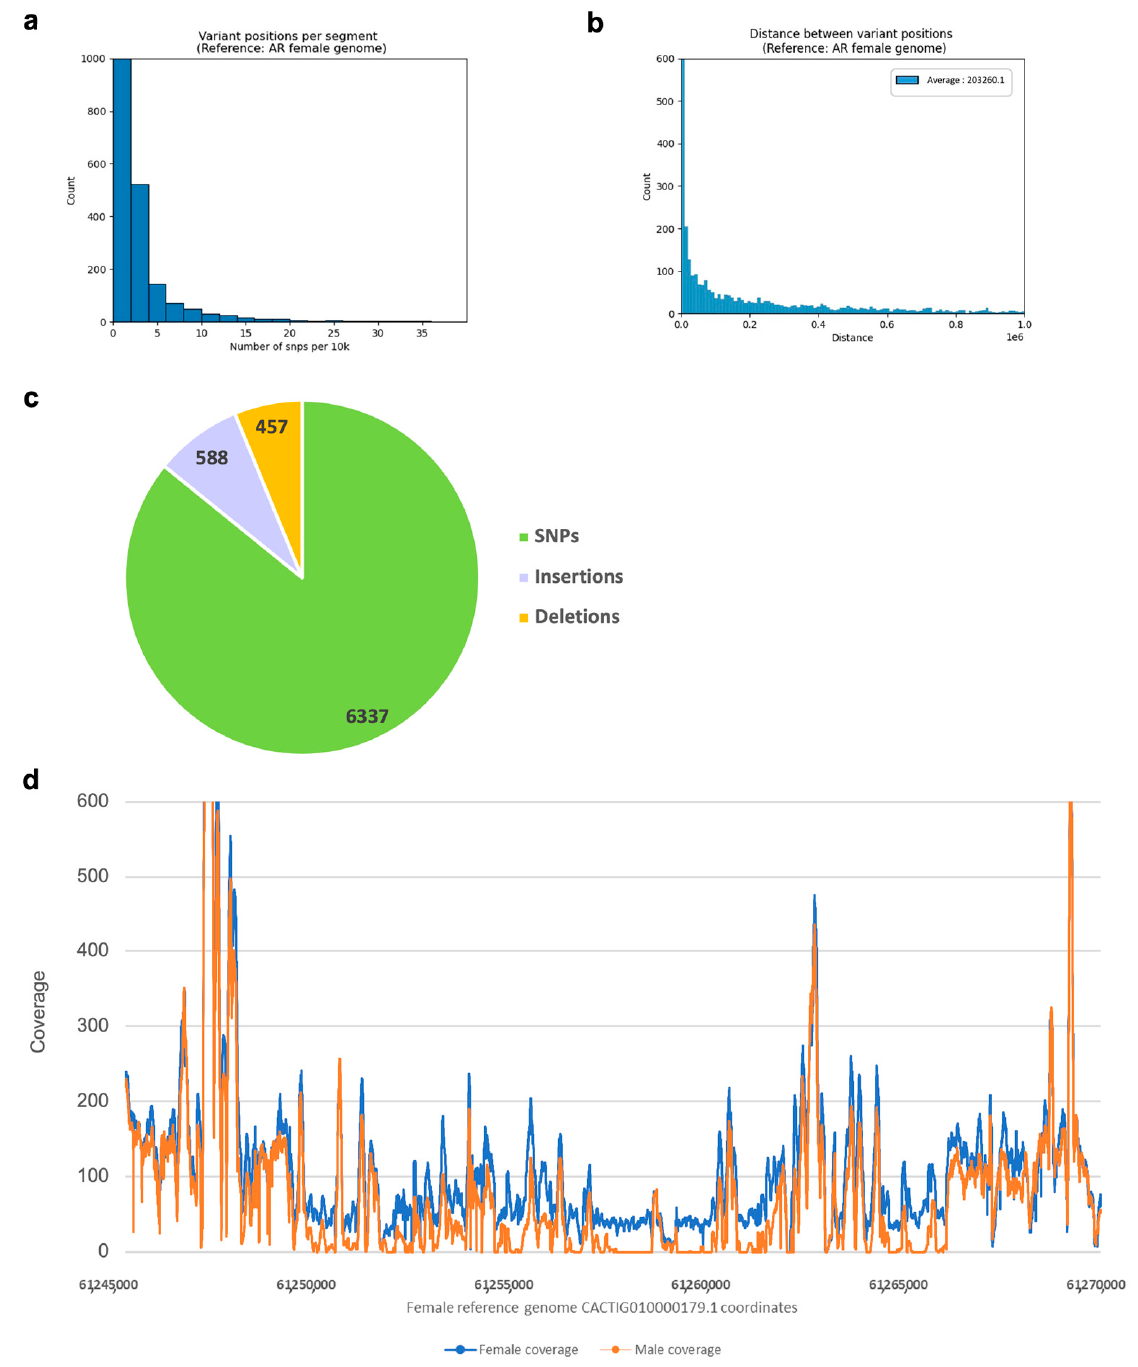
Figure 4. Inter-sex variation in AG. ( a , b ) Distributions of SNPs representing inter-sex genomic variation in AG, when mapping to the female reference. ( a ) SNPs per 10 kb segment; ( b ) distance between SNPs. ( c ) Pie chart representing the contribution of different types of variants (SNPs, insertions, and deletions) to the overall variation observed. ( d ) Aggregated coverage of AG WGS reads from 5 females (blue) and 5 males (red) in previously reported sex-variable region of the AR genome (female reference, contig CACTIG010000179.1). Note female-specific fragments between the positions 61,250,000 and 61,267,000 of the reference contig.